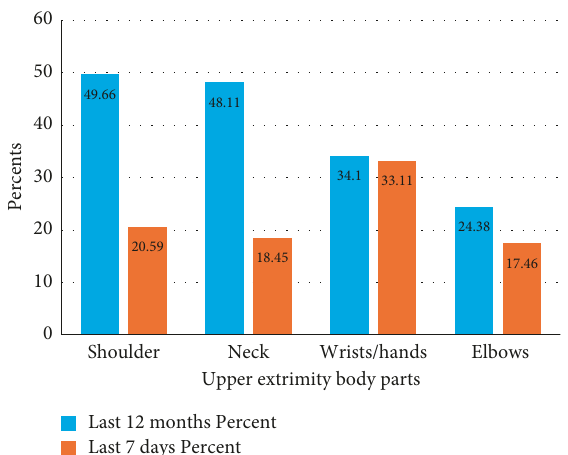
Figure 2: Prevalence of self-reported work-related upper extremity disorders of teaching staff in the University of Gondar,